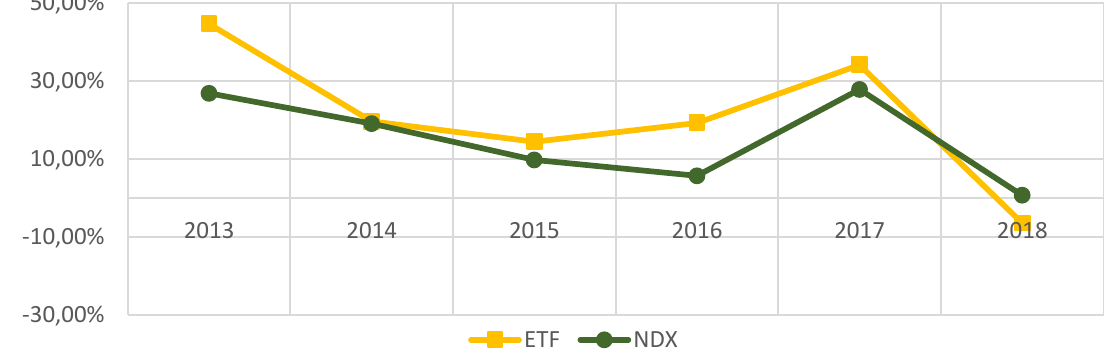
Figure 1. Annual return